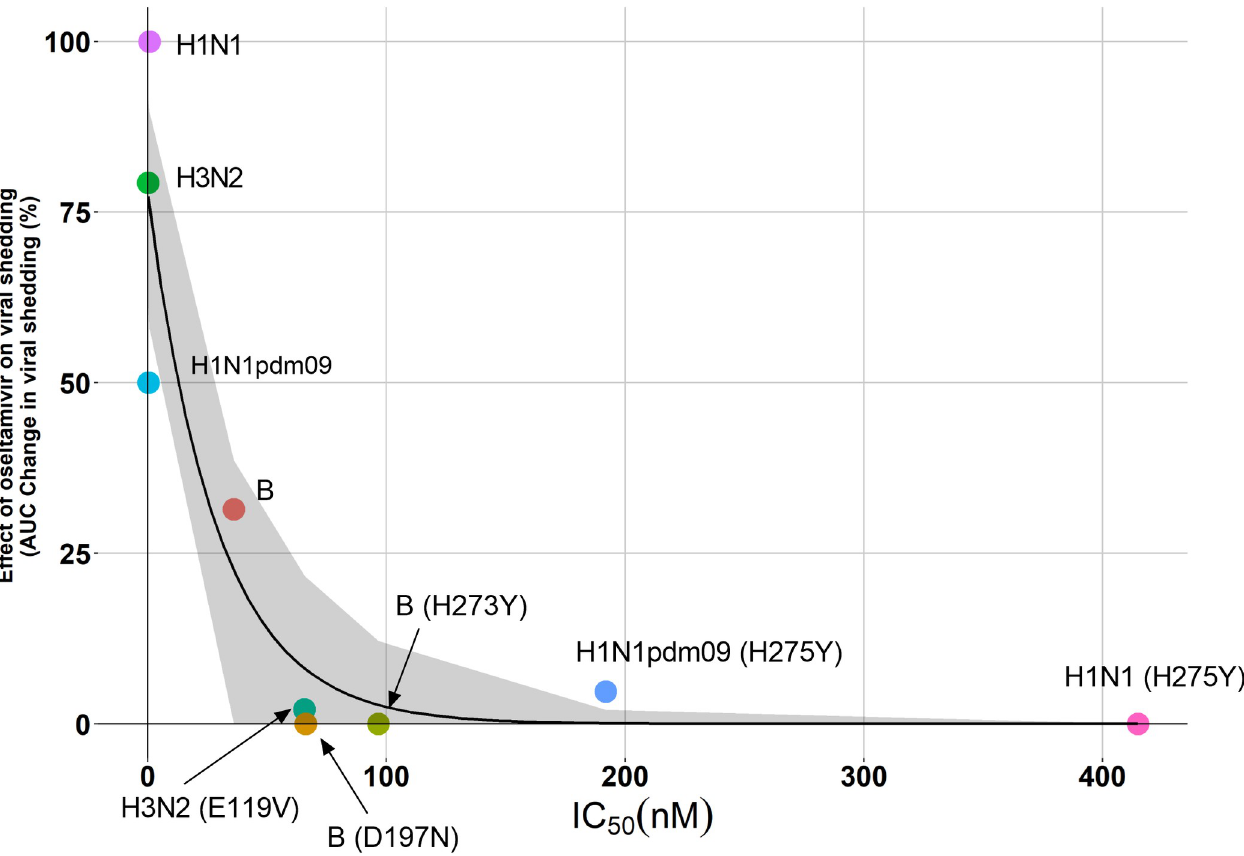
Fig 2. A scatter plot showing the relationship between % Δ AUC (difference between placebo and OST dosed animals) of viral shedding of ferrets and the OST IC 50 . This graph shows the significant correlation between in vitro OST IC 50 and in vivo effect on viral shedding. The regression model reveals the following relationship where y = e 4.35–0.03x . The shaded region of the graph is the 95% confidence interval of the line of best fit, calculated by bootstrapping over 2500